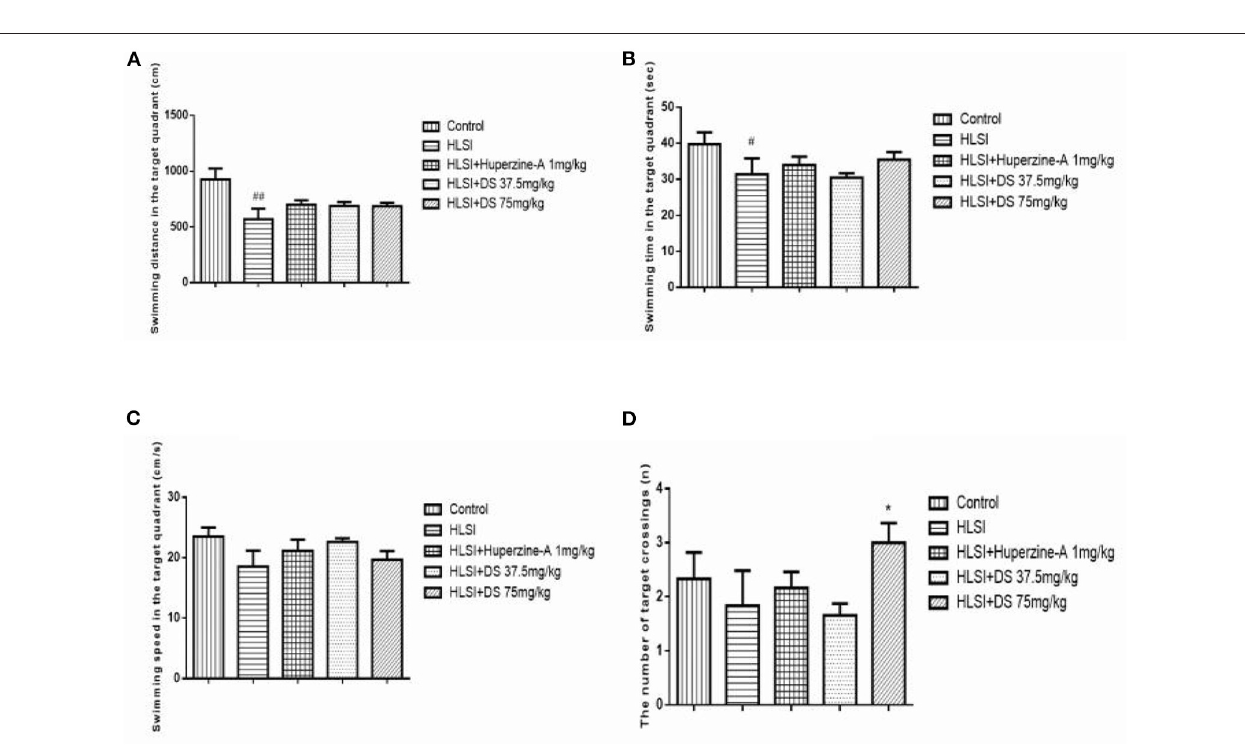
significantly ( p < 0.05 or p < 0.01). Huperzine-A (1 mg/kg) also produced an increase in ChAT activity ( p <